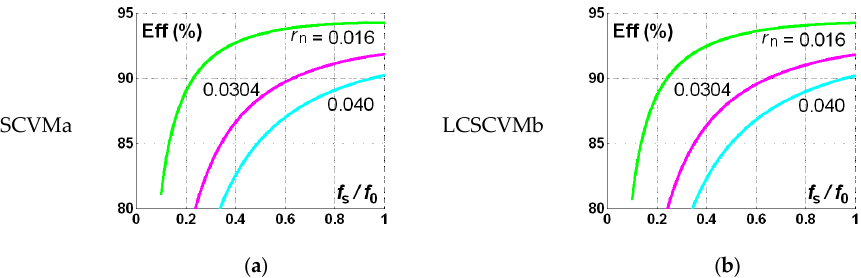
Figure 12. Theoretical charts of efficiency vs. f Sn = f S / f 0 for three values of r n : 0.016, 0.0304, and 0.040, and Δ U Dn = 0.008: ( a ) LCSCVMa at switching losses Δ P sw0n = 0.0138, ( b ) LCSCVMb at switching losses Δ P sw0n = 0.0101.